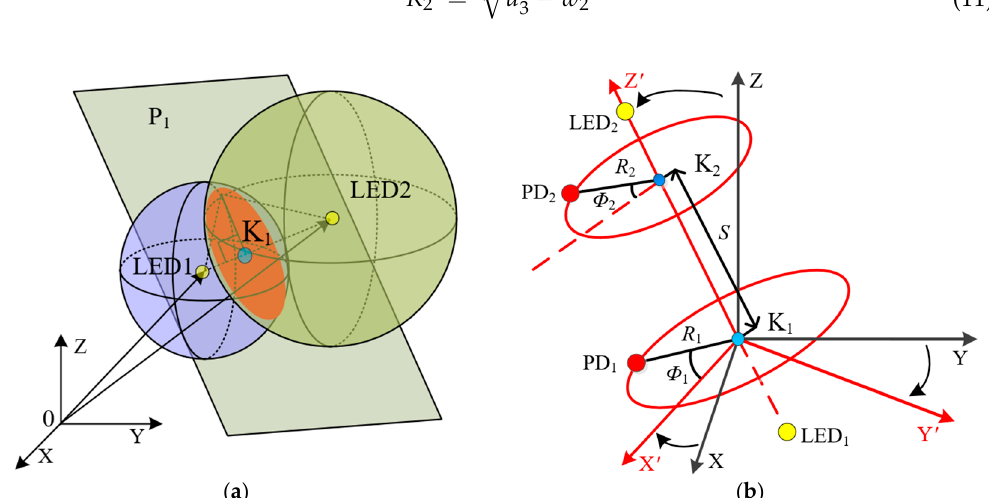
Figure 2. Schematic diagrams of the solving process: ( a ) establishing intersection circles; and ( b ) conducting coordinate transformations.